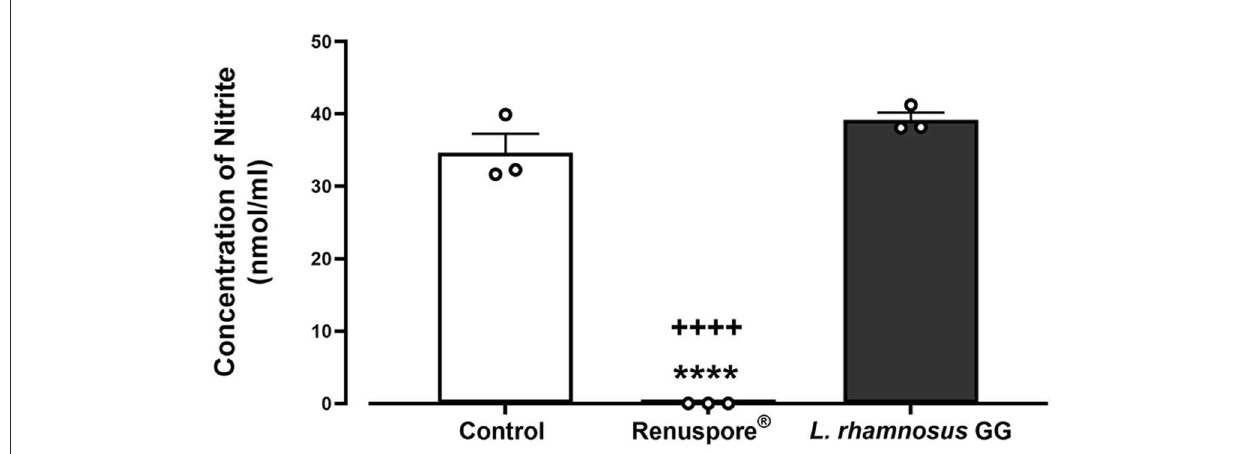
FIGURE4 Renuspore ® reduced nitrite present in TSB medium compared with L. rhamnosus GG. Results show average concentration ( n = 3) ± standard error. Significant reduction observed between control and Renuspore ® is indicated as **** p < 0.0001. Significant reduction observed between Renuspore ® and L. rhamnosus GG is indicated as ++++ p < 0.0001. Results were statistically analyzed using the one-way analysis of variance (ANOVA) (biological replicates n = 3) followed by Tukey’s multiple comparison test using GraphPad Prism v.9.